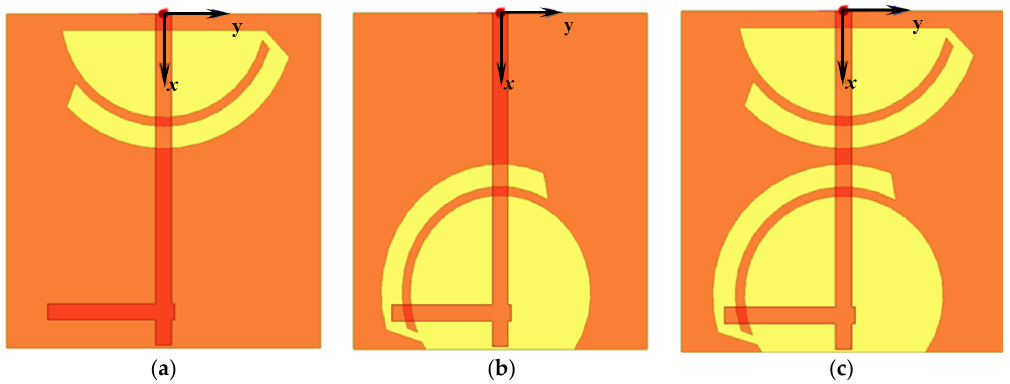
Figure 4. Comparison of three antennas configurations: ( a ) first partial slot antenna; ( b ) second partial slot antenna; and ( c ) final proposed antenna.